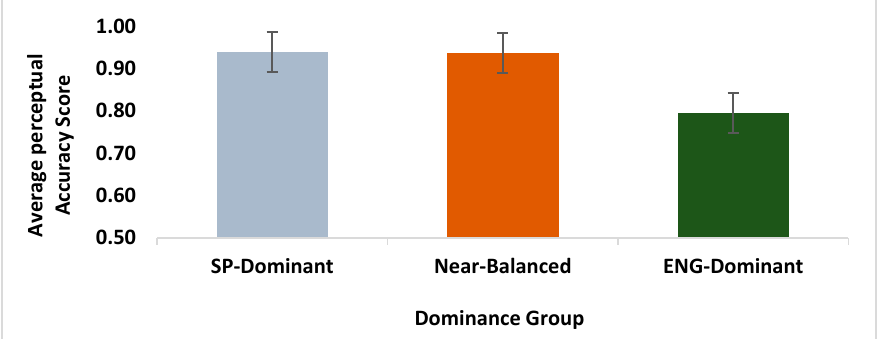
Figure 1. Average target token score per dominance group for all three contrast types combined: [ β ]/[b], [ δ ]/[d], [ ɣ ]/[g].